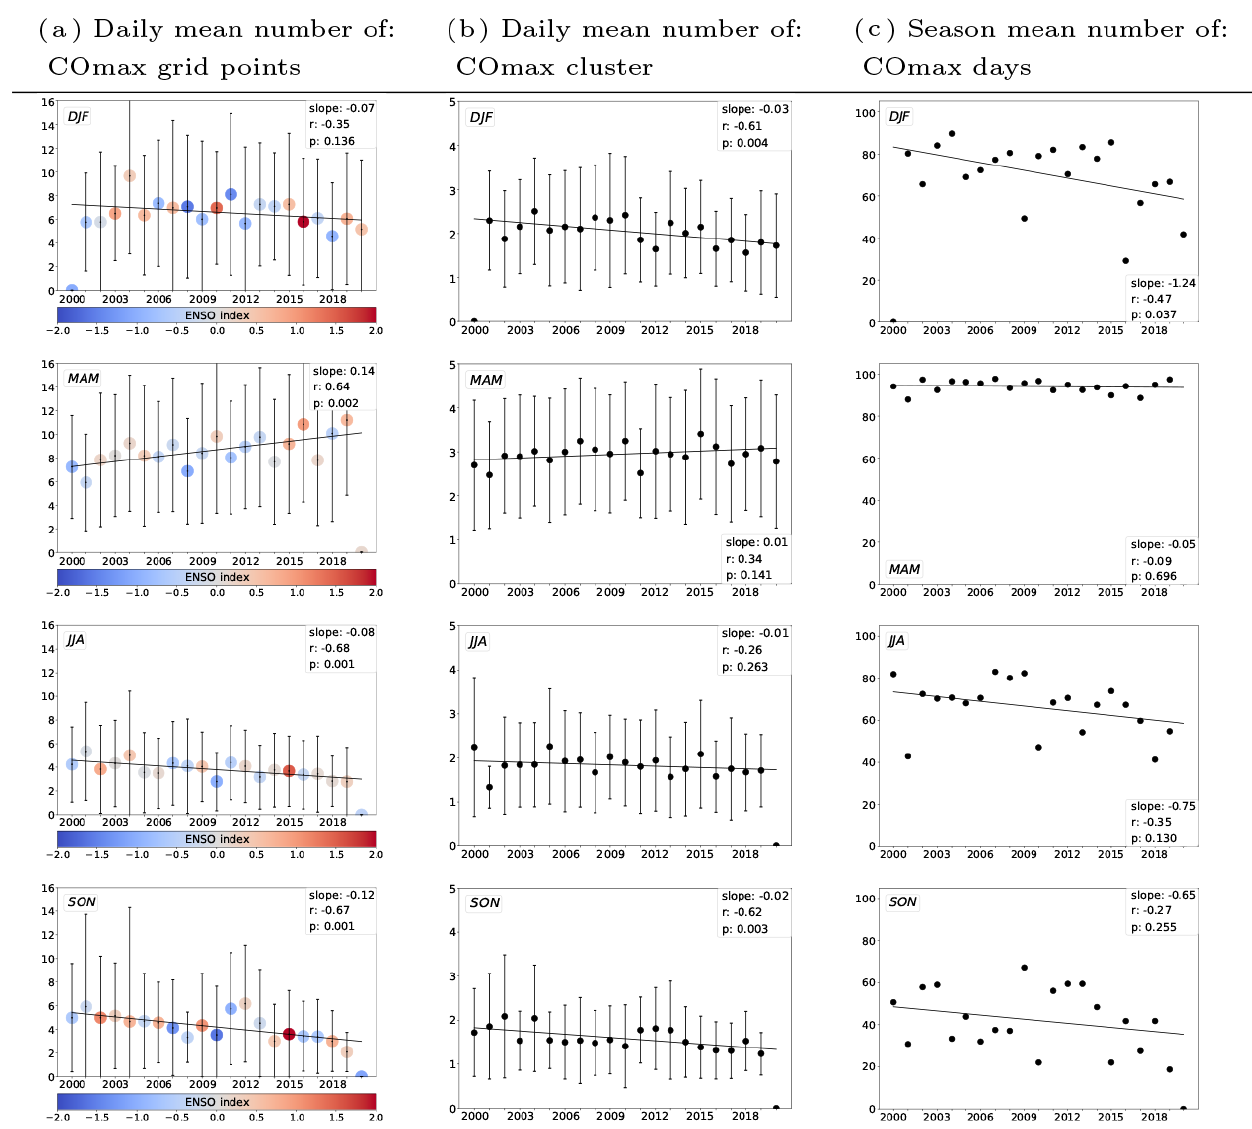
Figure 4. (a) Plots show time series of the season mean number of daily CO maxima grid points normalised by the total number of retrieved MOPITT data points over the NH Pacific. Circles are coloured according to the ENSO index (taken from https://origin.cpc.ncep.noaa. gov/products/analysis_monitoring/ensostuff/ONI_v5.php, last access: January 2022). Vertical lines show the standard deviation of the daily number of CO maxima grid points with respect to the season mean. Further shown are the season mean number of CO maxima cluster (b) and a percentage corresponding to the number of CO maxima days within one season weighted by the number of days with MOPITT data (c) . The area that is included in this analysis is shown in Fig. 3. Periods with data gaps are excluded from the statistics.